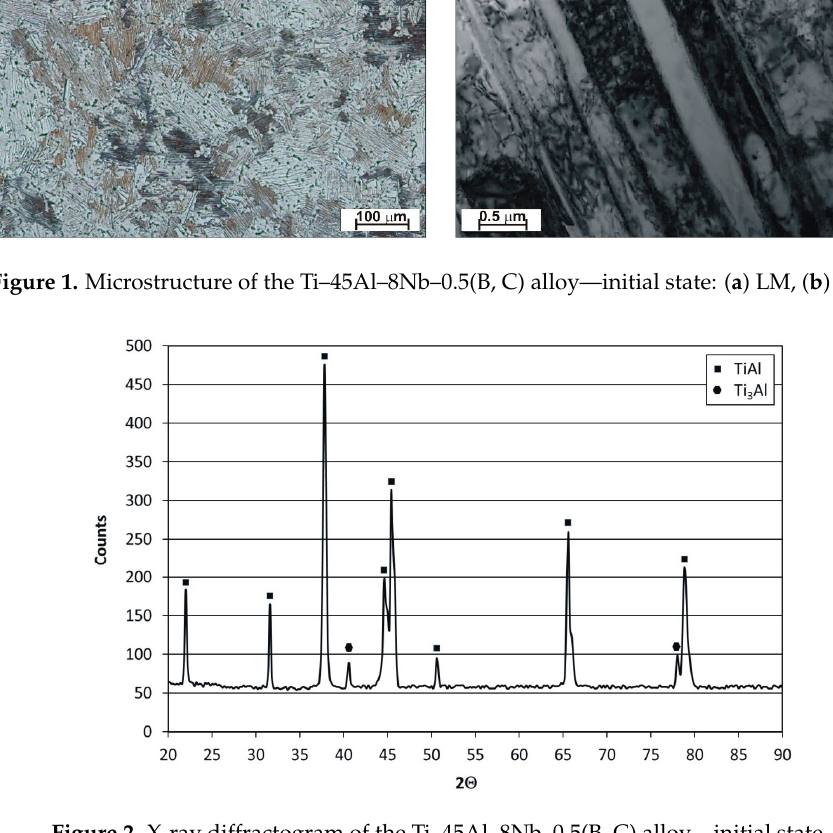
Figure 2. X-ray diffractogram of the Ti–45Al–8Nb–0.5(B, C) alloy—initial state.